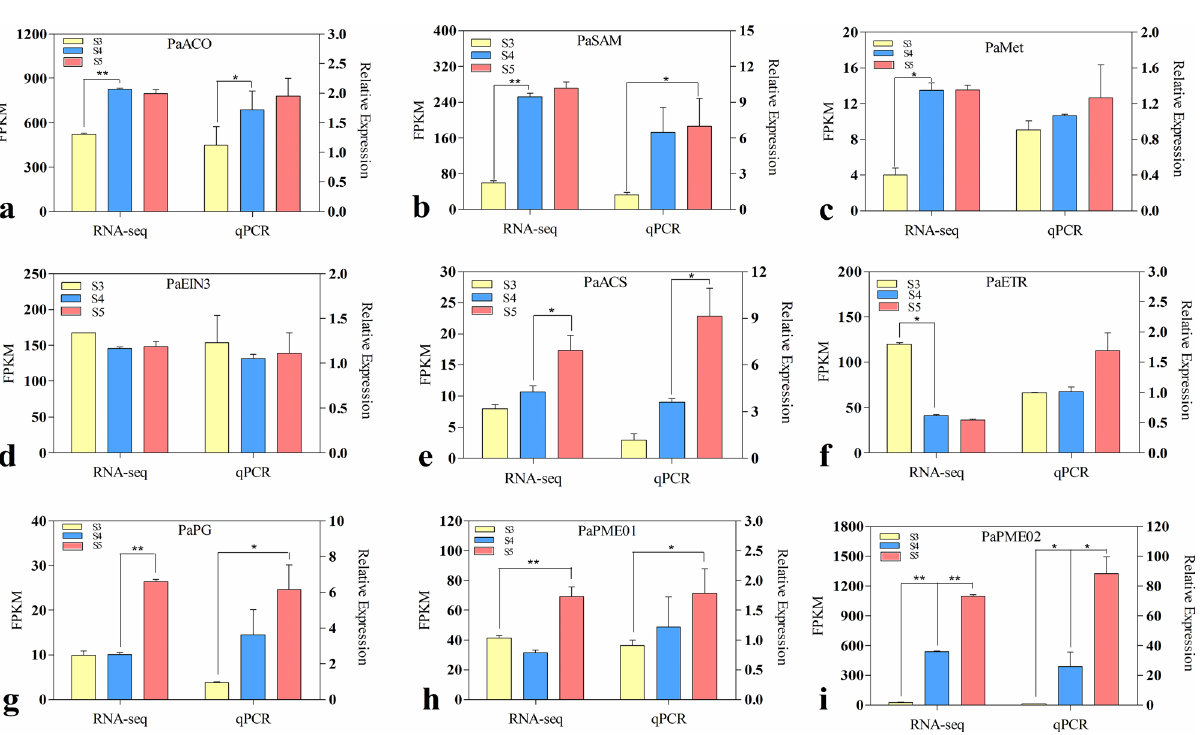
Figure 9. Verification of ethylene and cell wall metabolism-related DEGs by qRT-PCR. Note: All data are presented as means of three biological replicates, and error bars represent ± standard deviation. * indicates